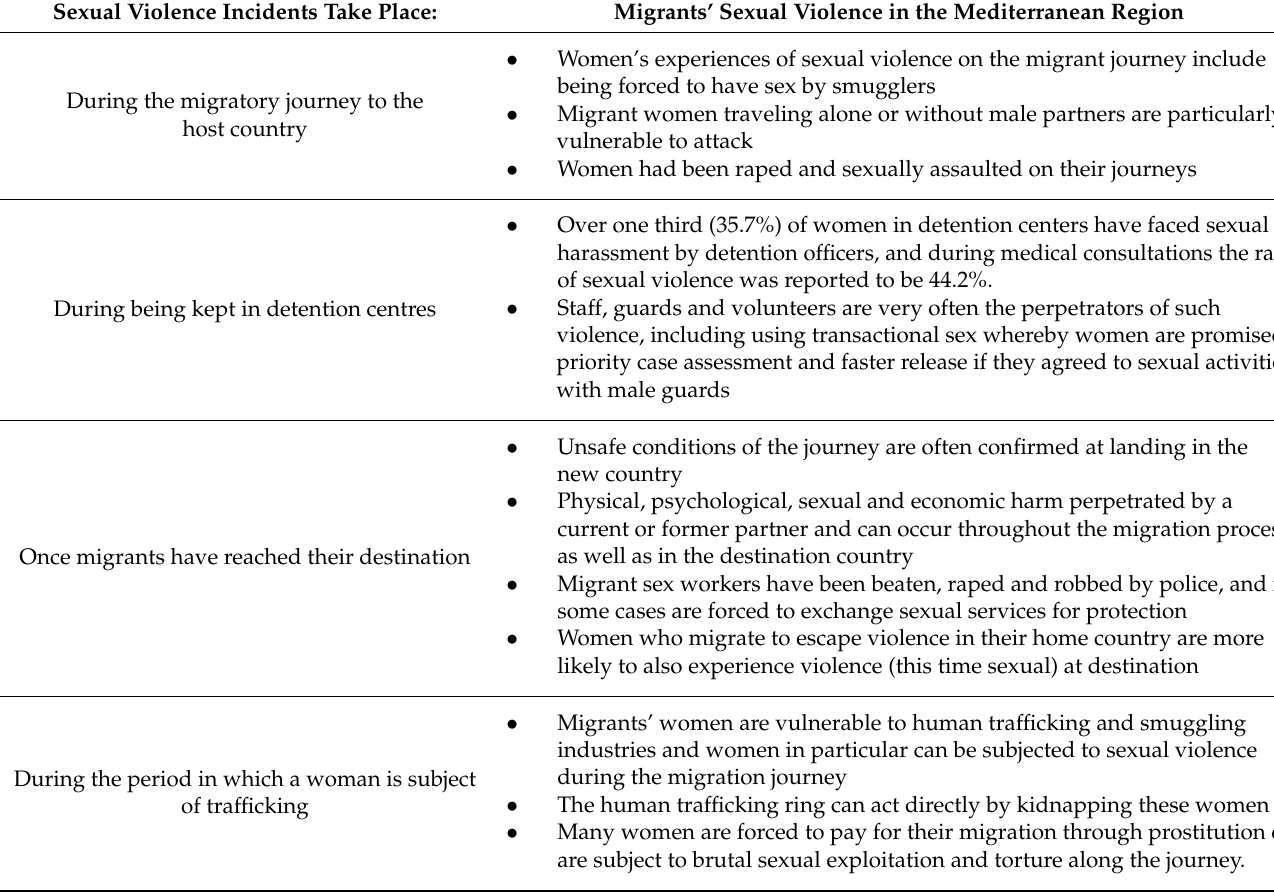
Table 1. Main findings based on literature